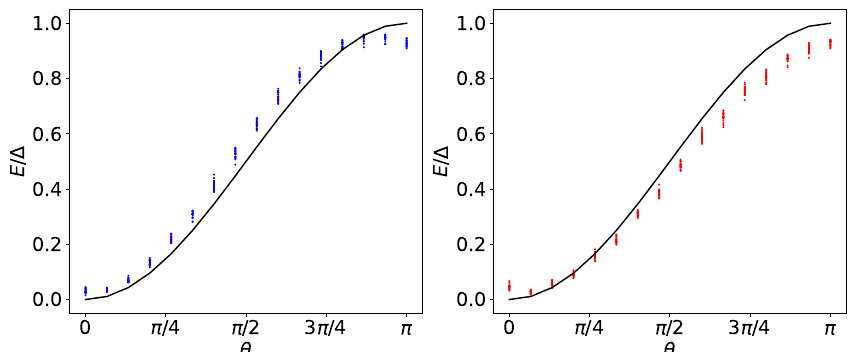
Figure 2. (Color online). Energy stored in the QB (in units of ∆ ) as a function of the area θ . The black curves correspond to the ideal charging profile with a = 1 (see Equation (33)). The left panel shows the charging achieved using a Gaussian pulse with fixed standard deviation σ = t m /8, being √ t m = 600 ns the measurement time, and amplitude N = θ / ( 2 π g σ ) . The right panel shows the charging due to a Gaussian pulse with fixed amplitude equal to N = 1 and adjustable standard √ deviation σ = θ / ( 2 π g N ) . The vertical spread of the points is due to the fact that we have considered 20 measurements for each value of θ